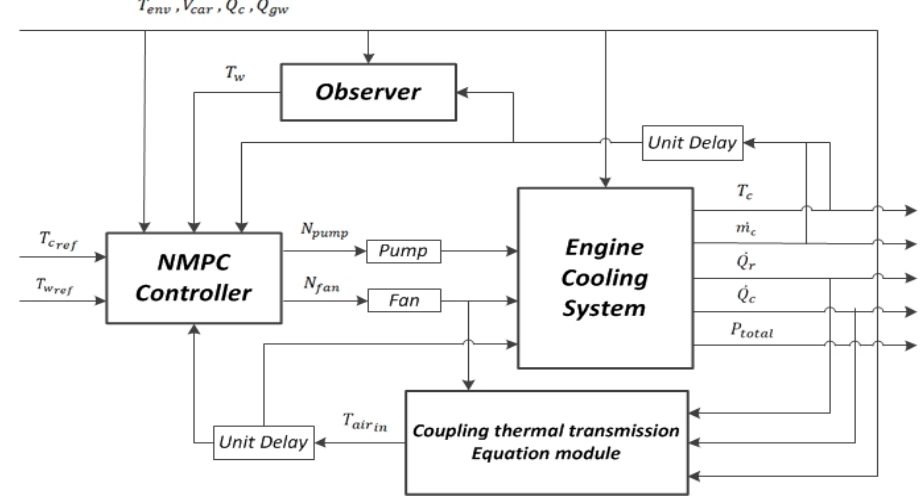
Figure 16. Schematic diagram of the NMPC control process for the engine cooling system.